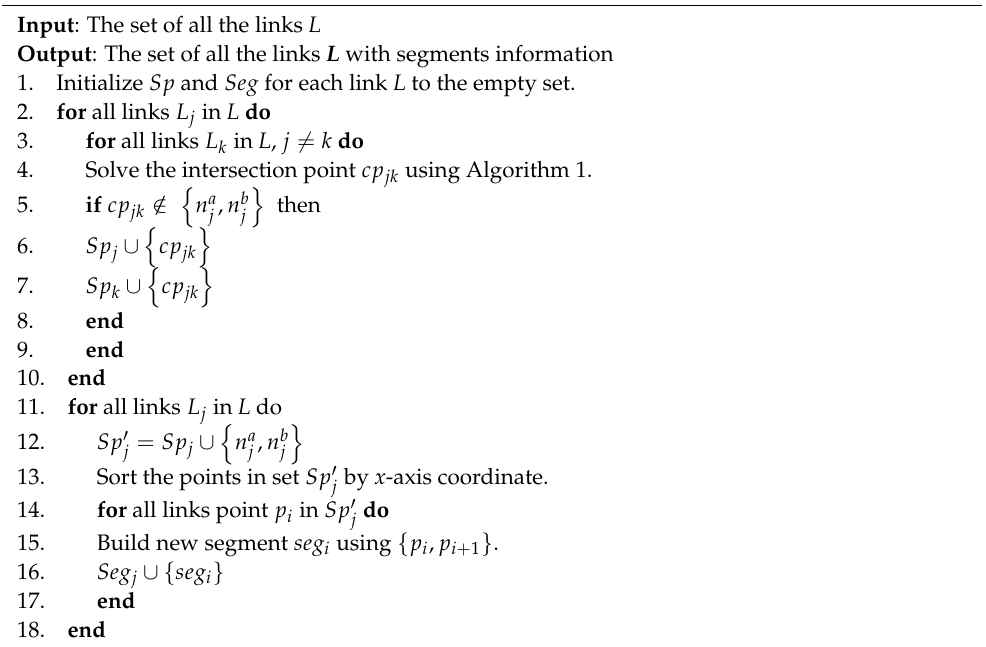
Algorithm 2 Calculate intersection point and segments of